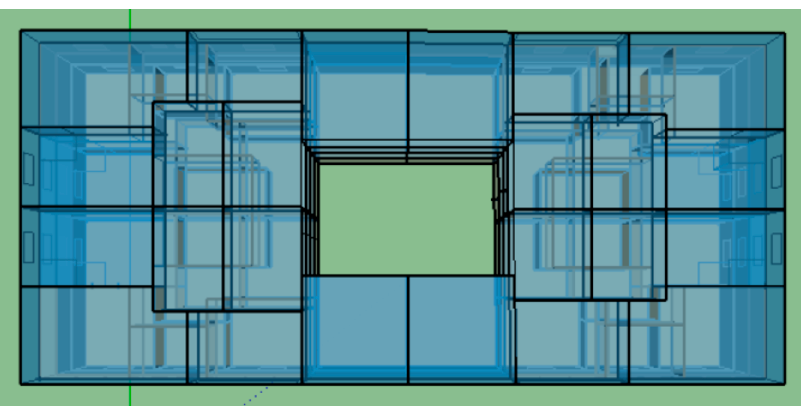
Figure 9. A view of the building corresponding to configuration 3.